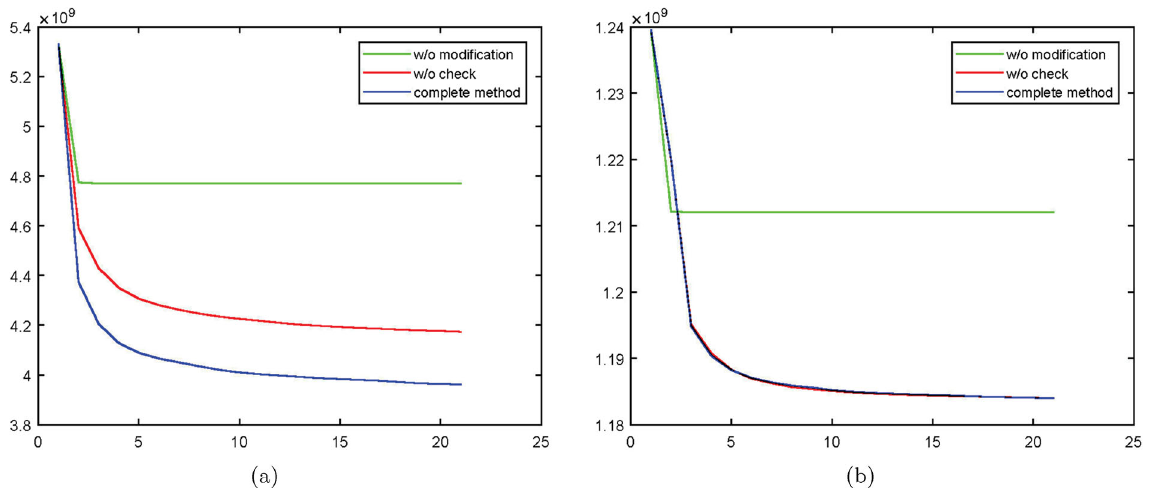
Fig. 8 Energy change during optimization. (a) Image pair with large displacement. (b) Image pair with small displacement.